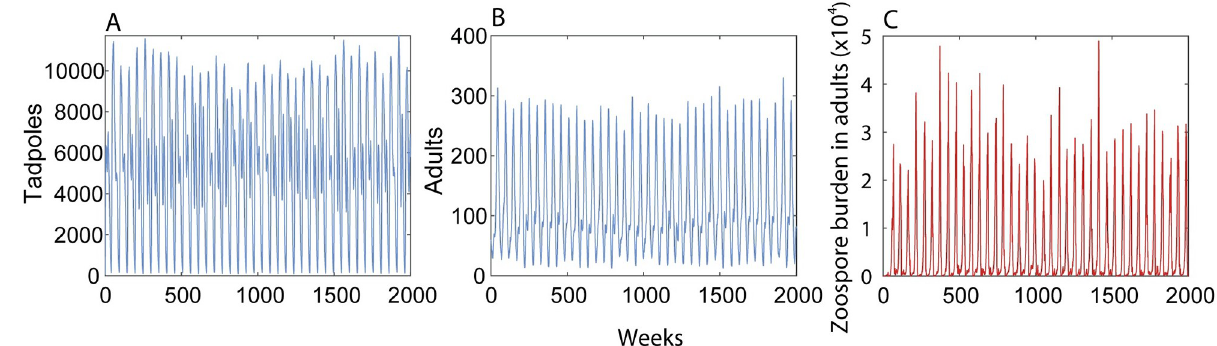
Fig 2. Long-term dynamics of the Atelopus cruciger – Bd interaction. Tadpoles and adults can get infected but only adults develop lethal chytridiomycosis. Simulations for 2,000 weeks show stable oscillations in the abundance of tadpoles, adults, and in the zoospore burden.